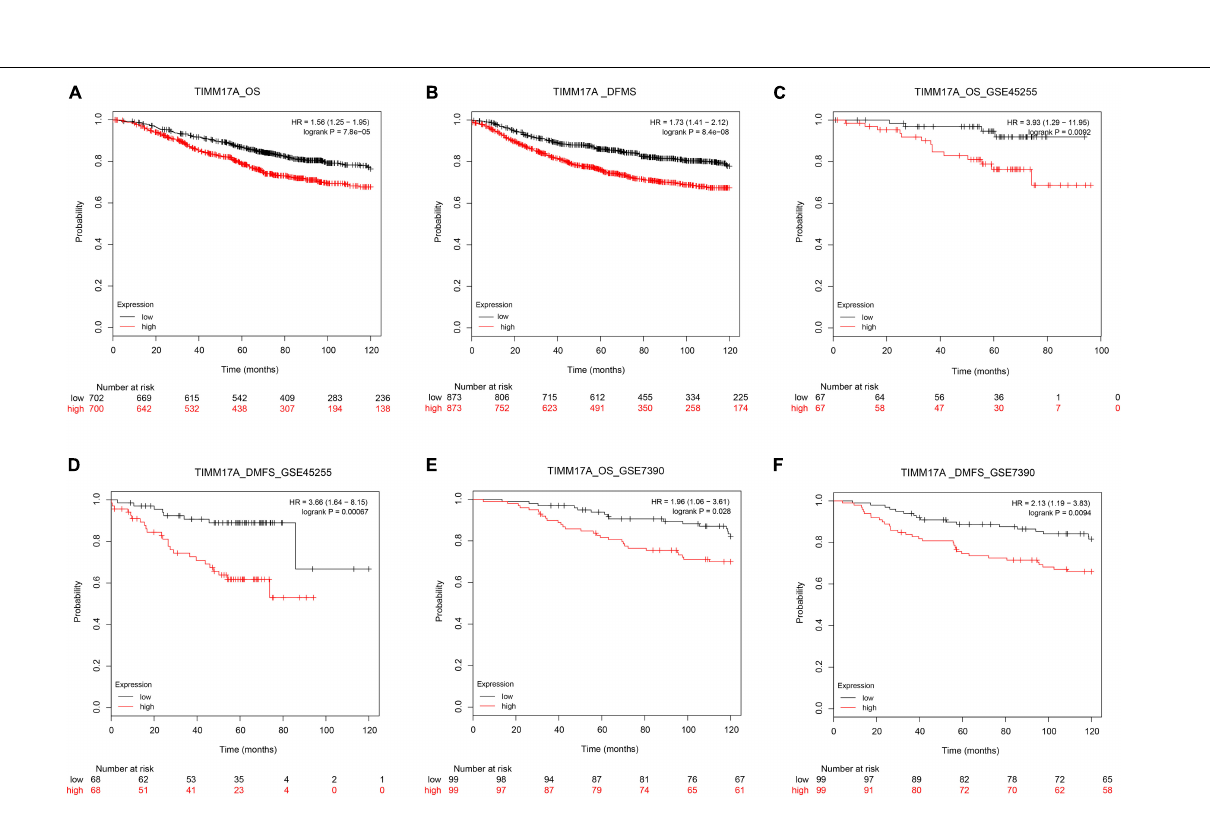
Frontiers in Genetics |